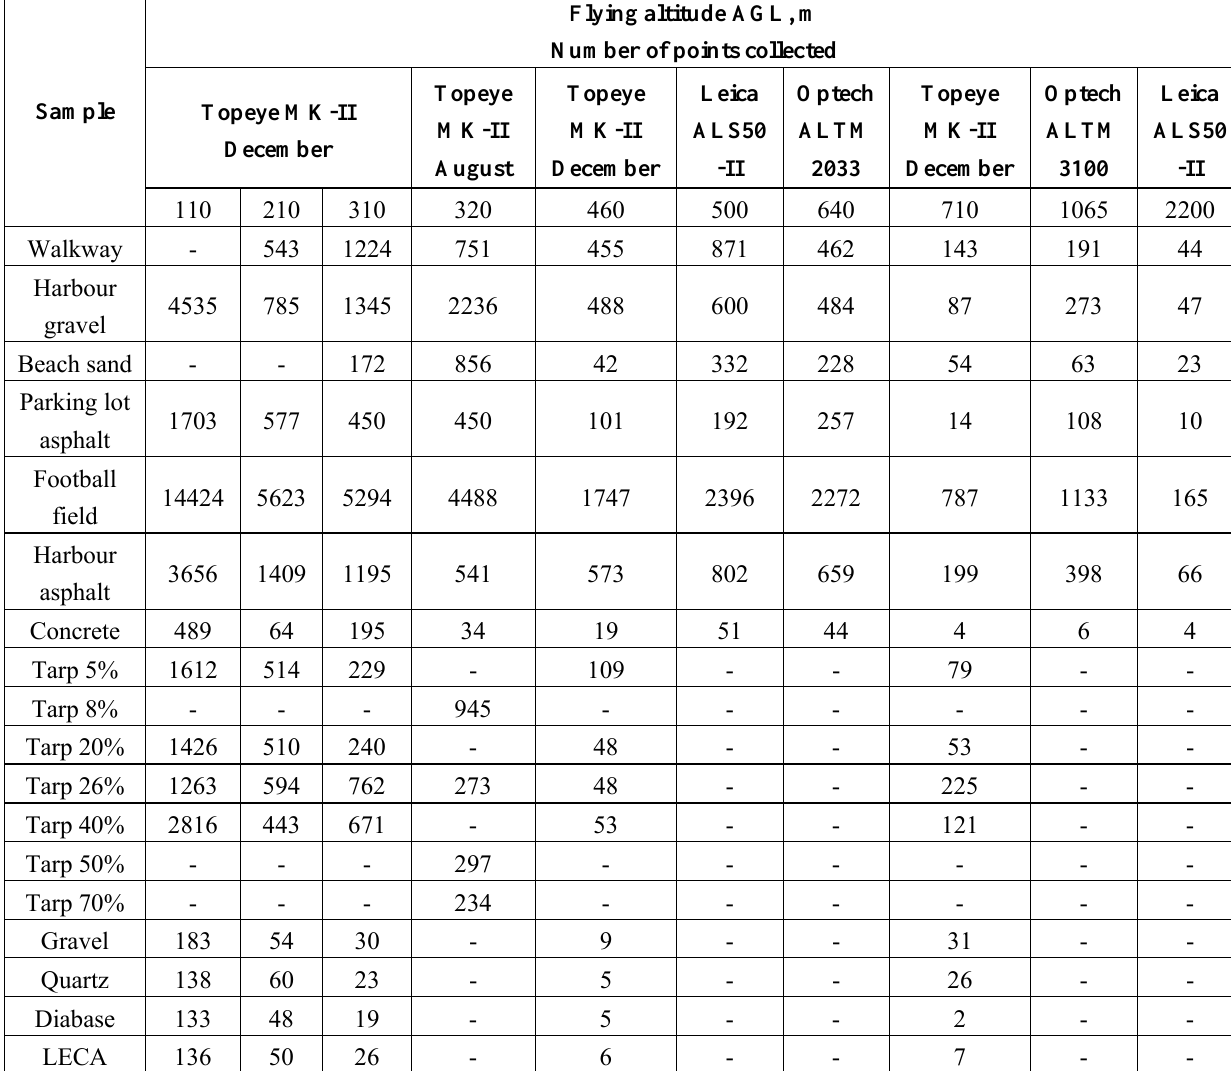
Table 2. Data series of samples taken from the ALS data. Number of points collected for every sample and flying